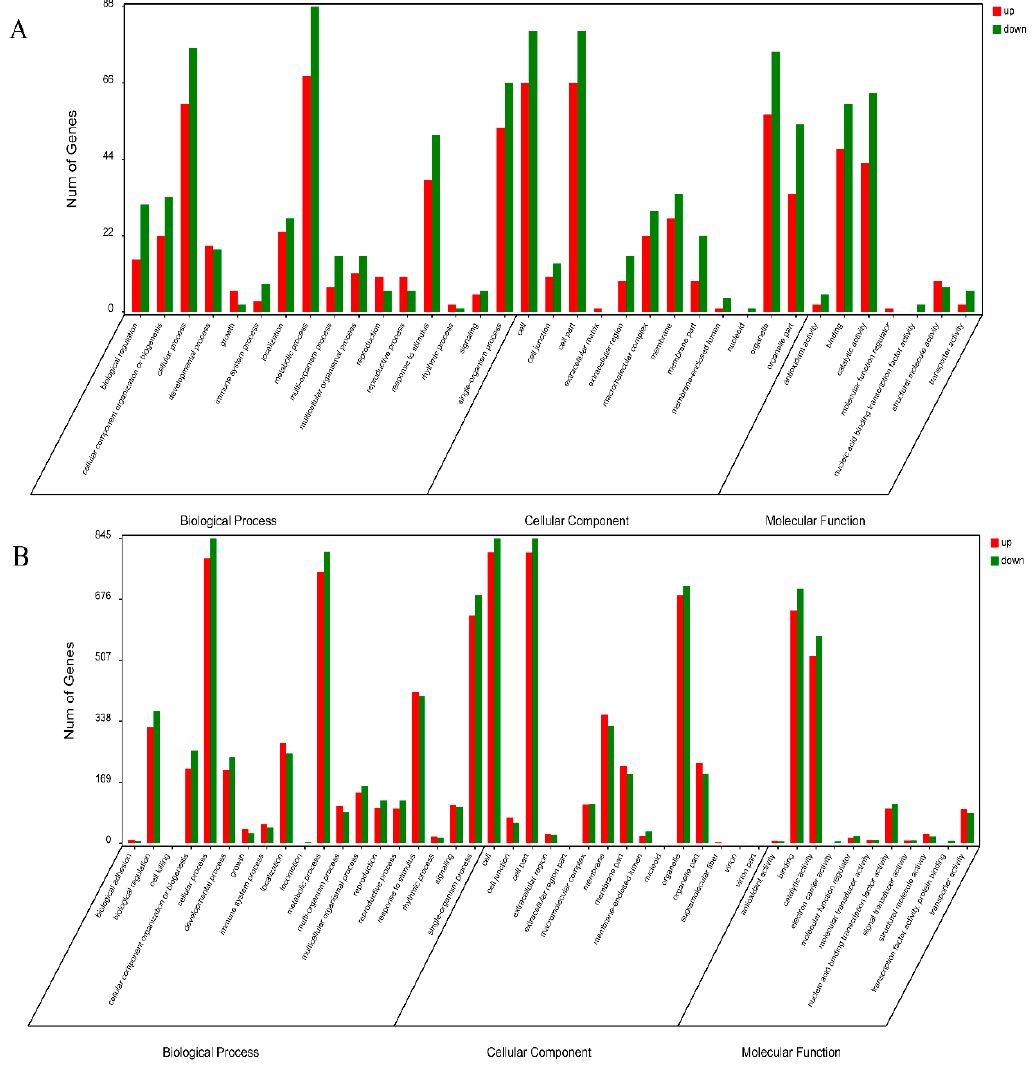
Figure 3. ( A ) Gene ontology categories for differential abundance protein species in the proteome data; ( B ) gene ontology categories for differentially expressed genes in the transcriptome data.